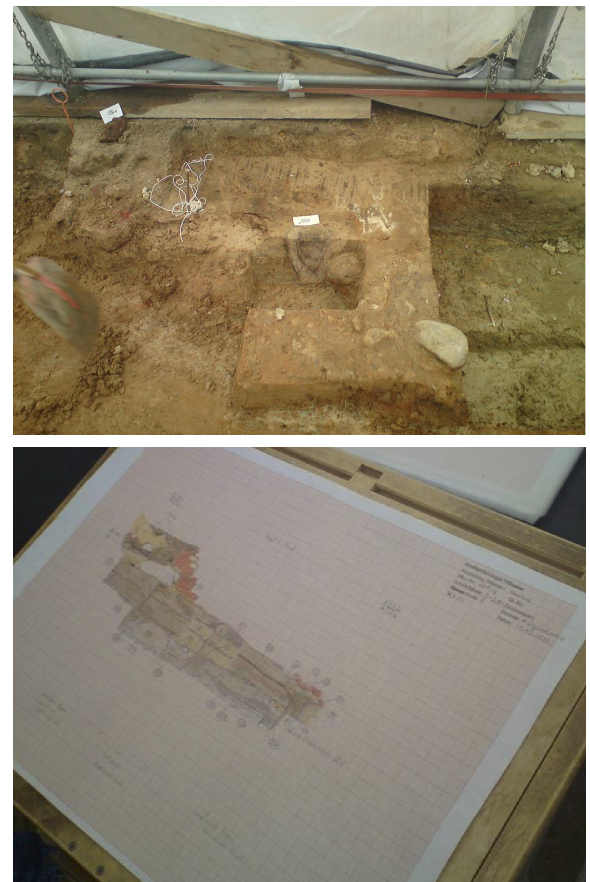
Figure 1: Top: An excavation site located at “Haus Kump”, a building from the 16th century, which is the oldest storage build- ing in M¨unster, Germany. Bottom: Findings on a graph paper that were meticulously sketched by an archaeologist on